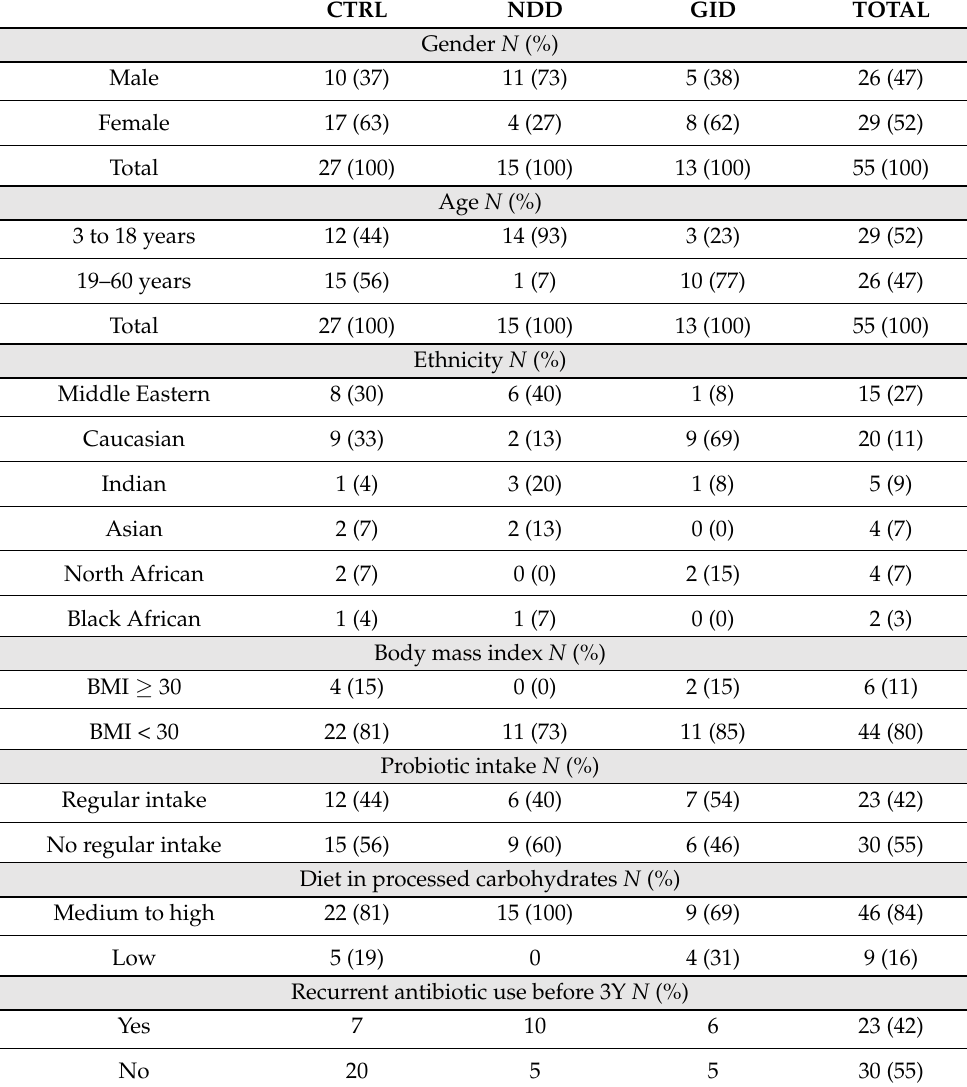
Table 1. Characteristics of the studied